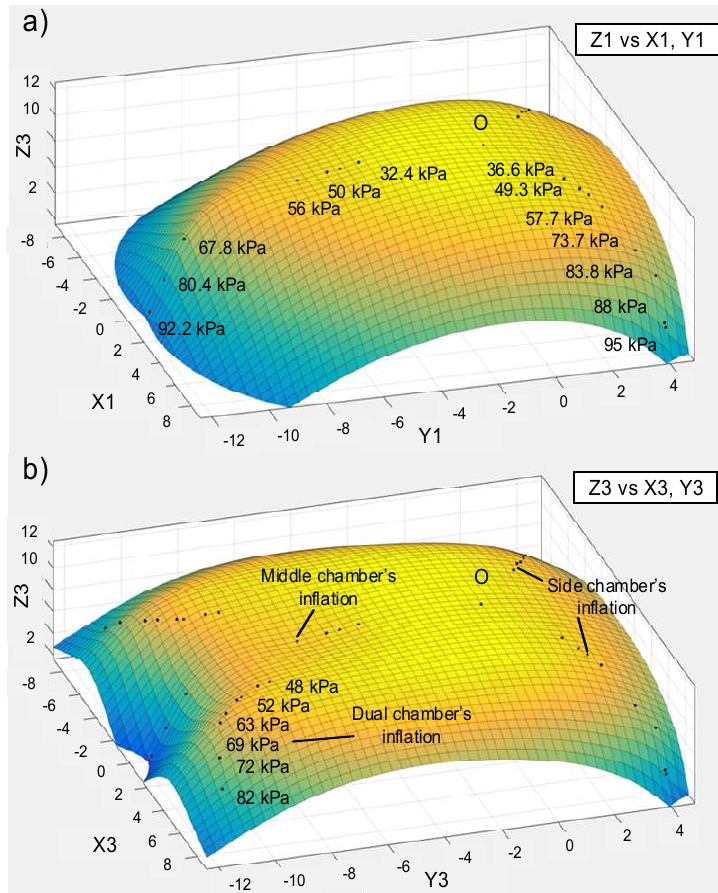
Figure 9. 3D curve demonstrating the position of the fingertip based on results from the experiments: ( a ) Middle and side chamber’s inflation and ( b ) single- and dual-chamber inflation.